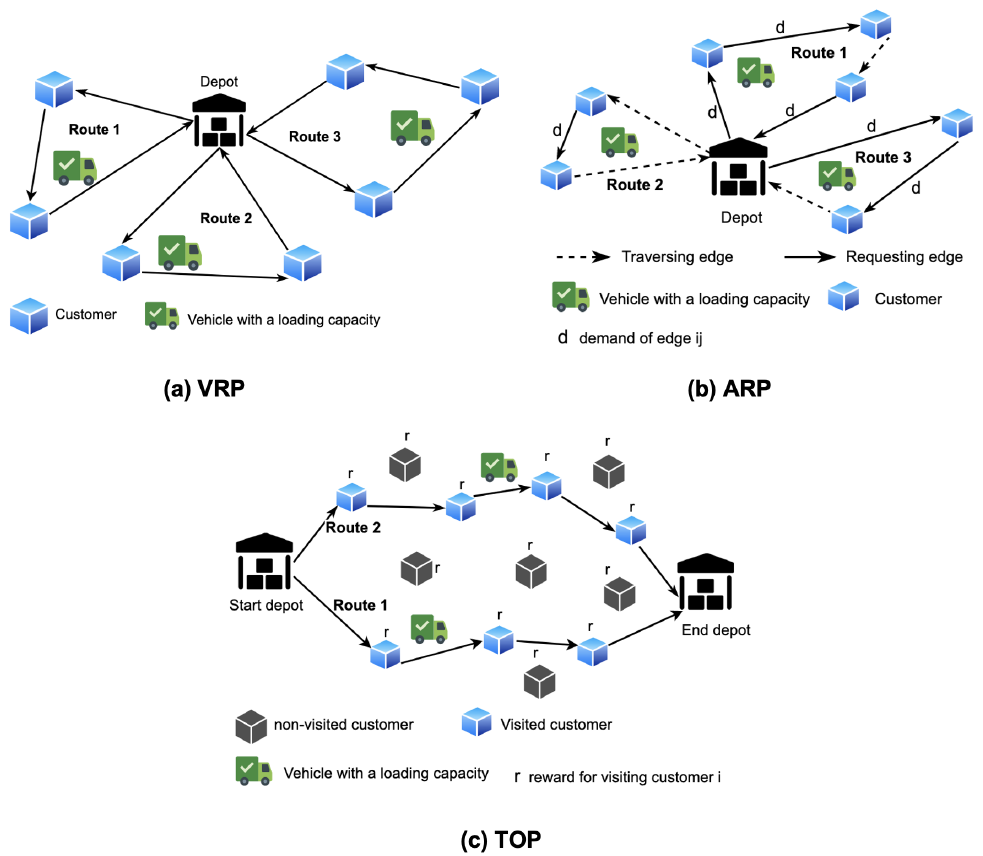
Figure 1. A schematic representation of a simple VRP, ARP, and